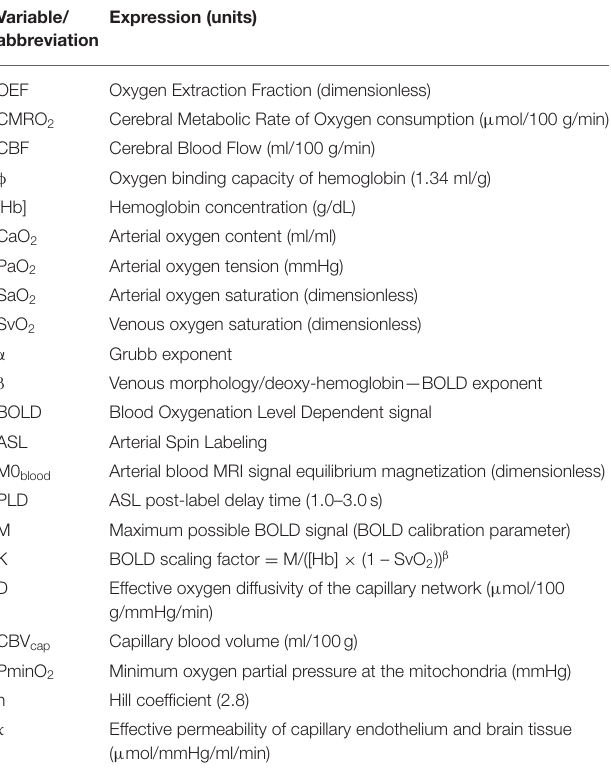
TABLE 2 | Summary of model parameters and abbreviation used in the dc-fMRI data simulations and their definitions. Variable/ Expression (units) abbreviation